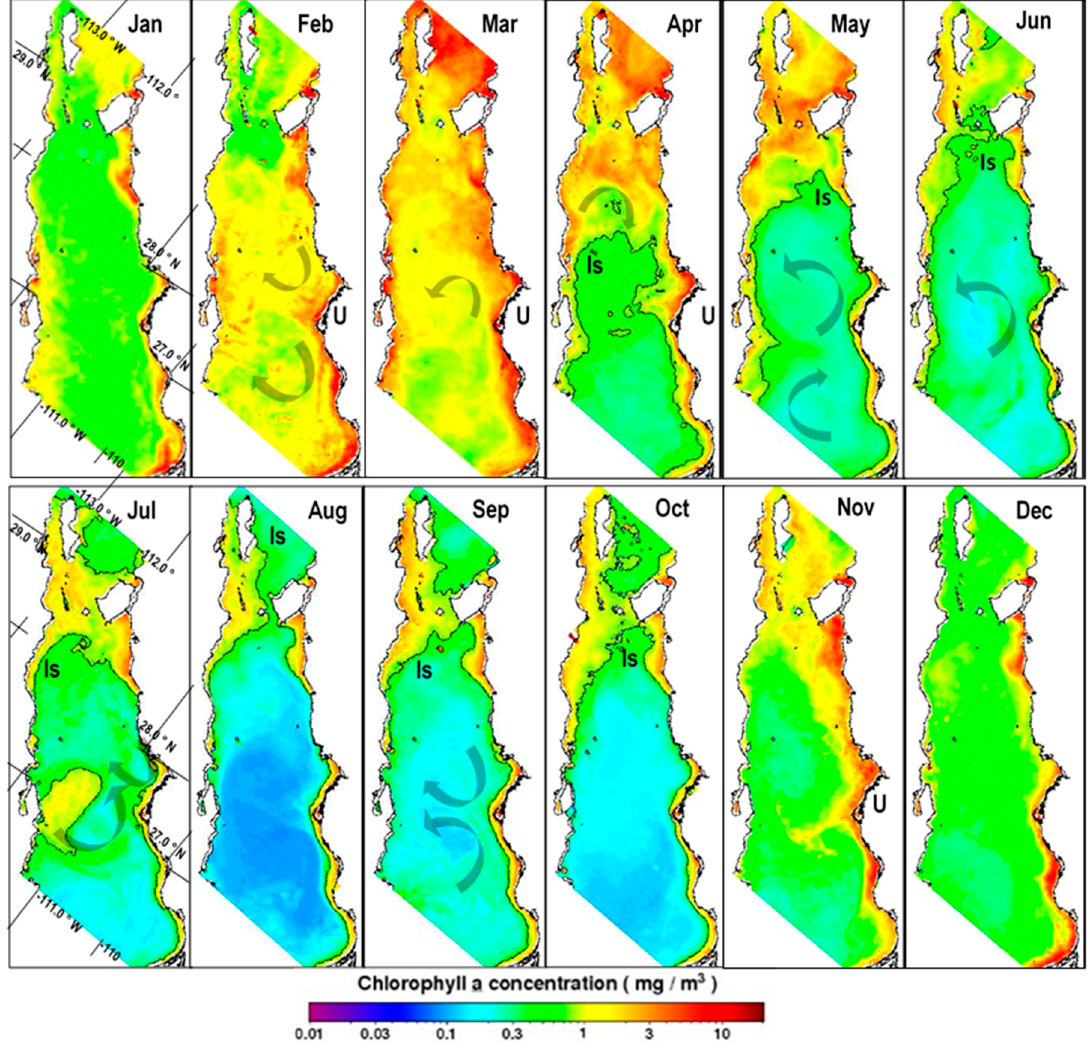
Figure 4. Satellite images of chlorophyll a mg/m 3 concentration in 2004. Isoline of Chl-a of 1 mg/m 3 (Is) and upwelling (U). Arrows in the clockwise direction indicate anti-cyclonic gyres, and those in the counterclockwise direction indicate cyclonic gyres.